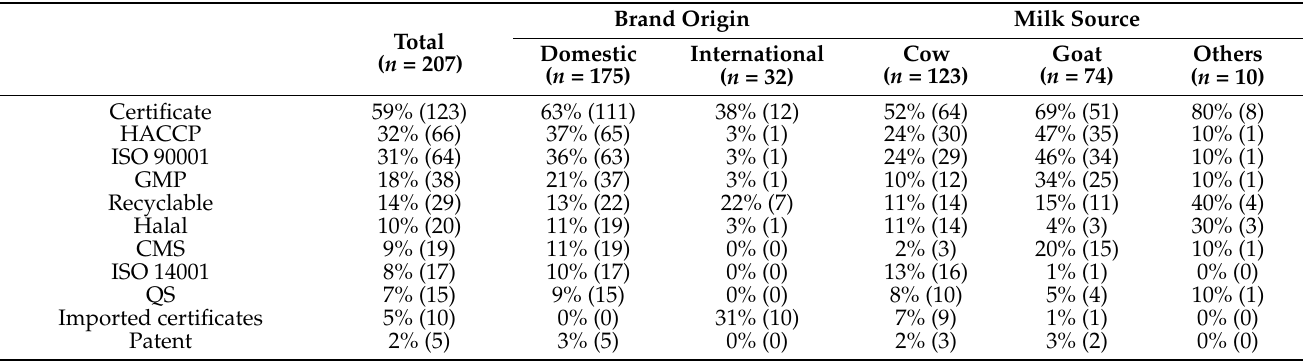
Table 7. Percentage and number of milks targeting Chinese older adults providing third party originated voluntary well-being messaging, certificates and patents, by total, brand origin and by milk source 1